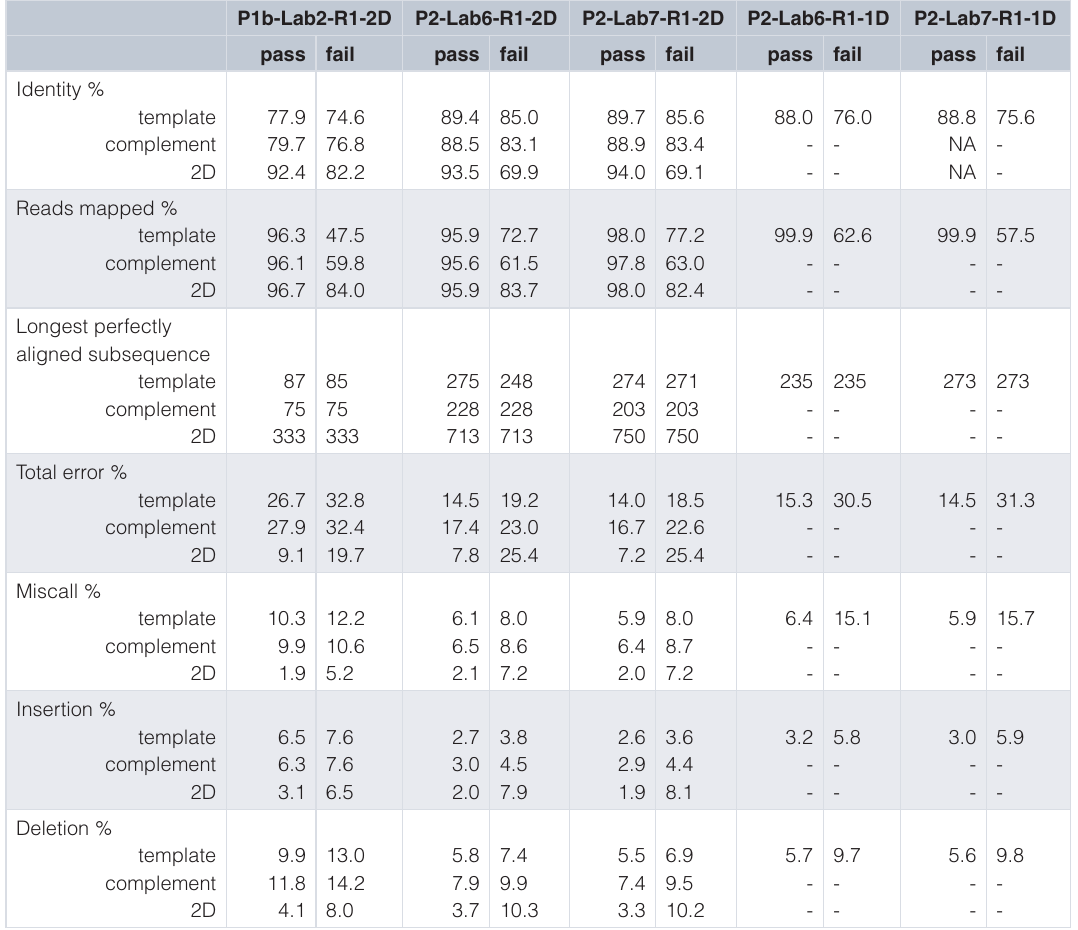
Table 4. Per-read accuracy metrics for target E. coli sample. (“-”) indicates the metrics were not applicable for that experiment. NA: not